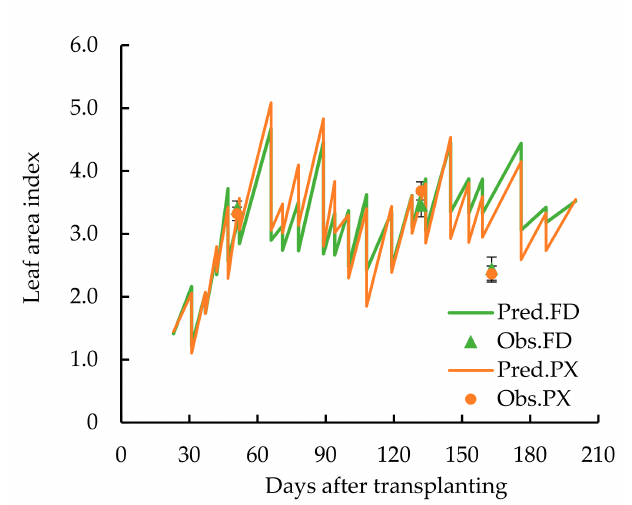
Figure 5. Simulated observed leaf area index (LAI) in two cucumber cultivars. Observed LAIs show the average ± SE (51, 132, and 163 d after transplantation, n = 6).